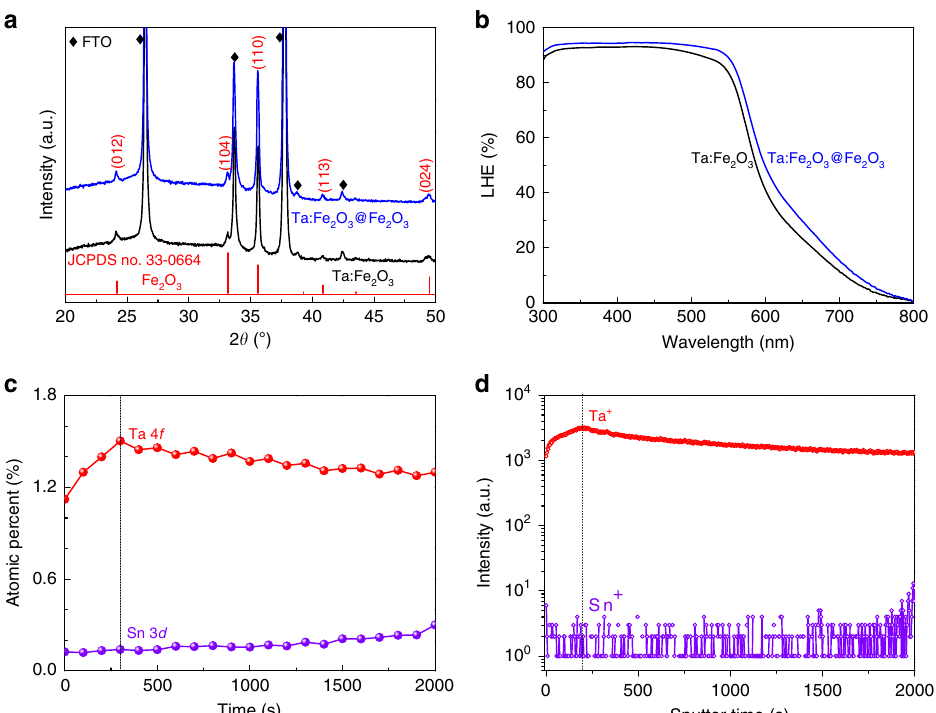
Fig. 3 Physical characterization of homojunction nanorod. a XRD and b LHE for Ta:Fe 2 O 3 and Ta:Fe 2 O 3 @Fe 2 O 3 , and c XPS and d TOF-SIMS depth pro fi les for Ta:Fe 2 O 3 @Fe 2 O 3